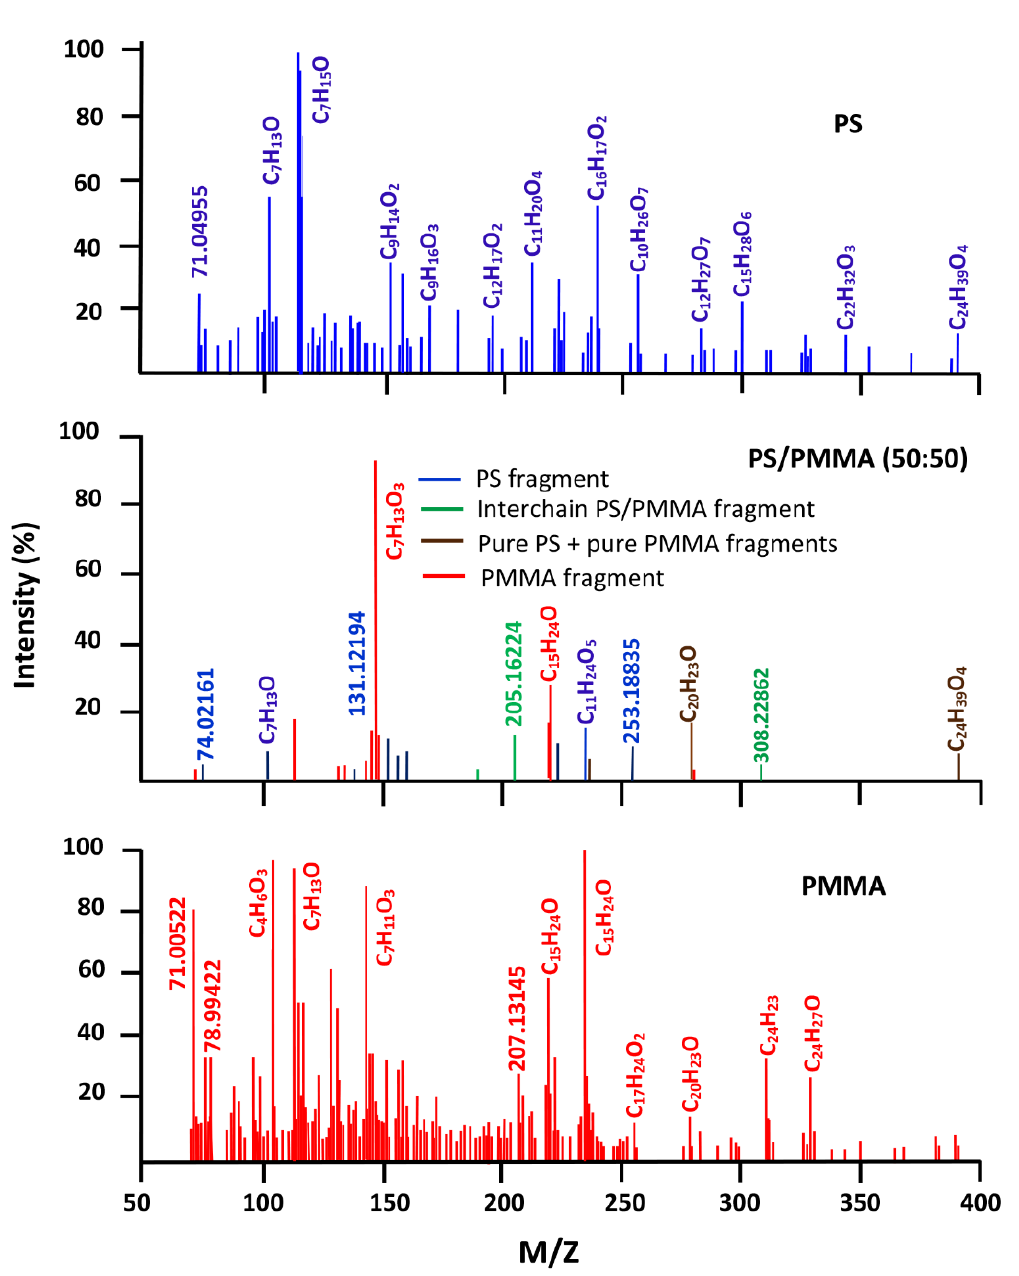
Figure 10. Comparative spectra of pure PS, PMMA, and their blend with 50 wt% of each compo- nent.